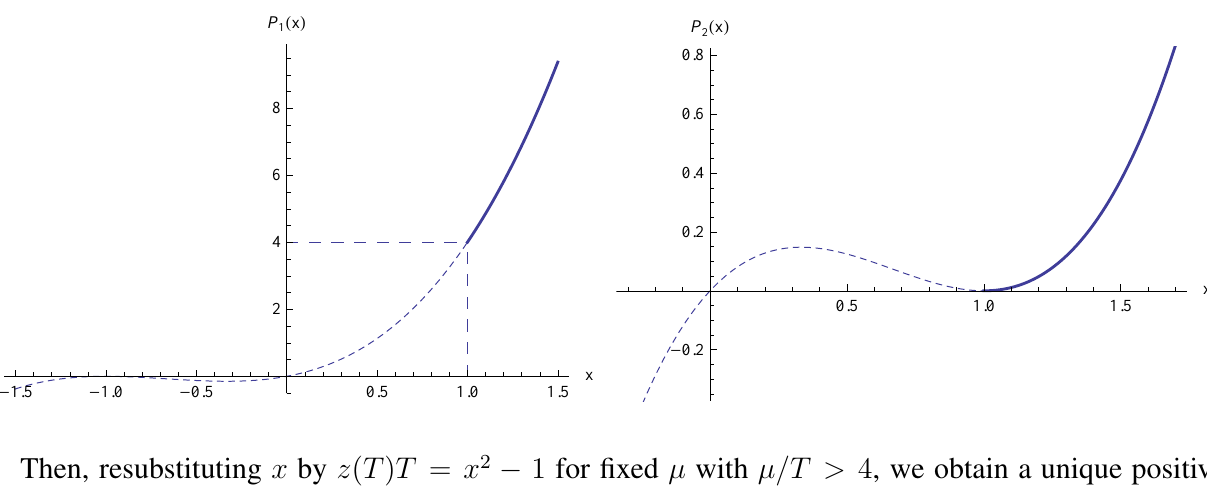
( x ) = x ( x +1) 2 and P 1